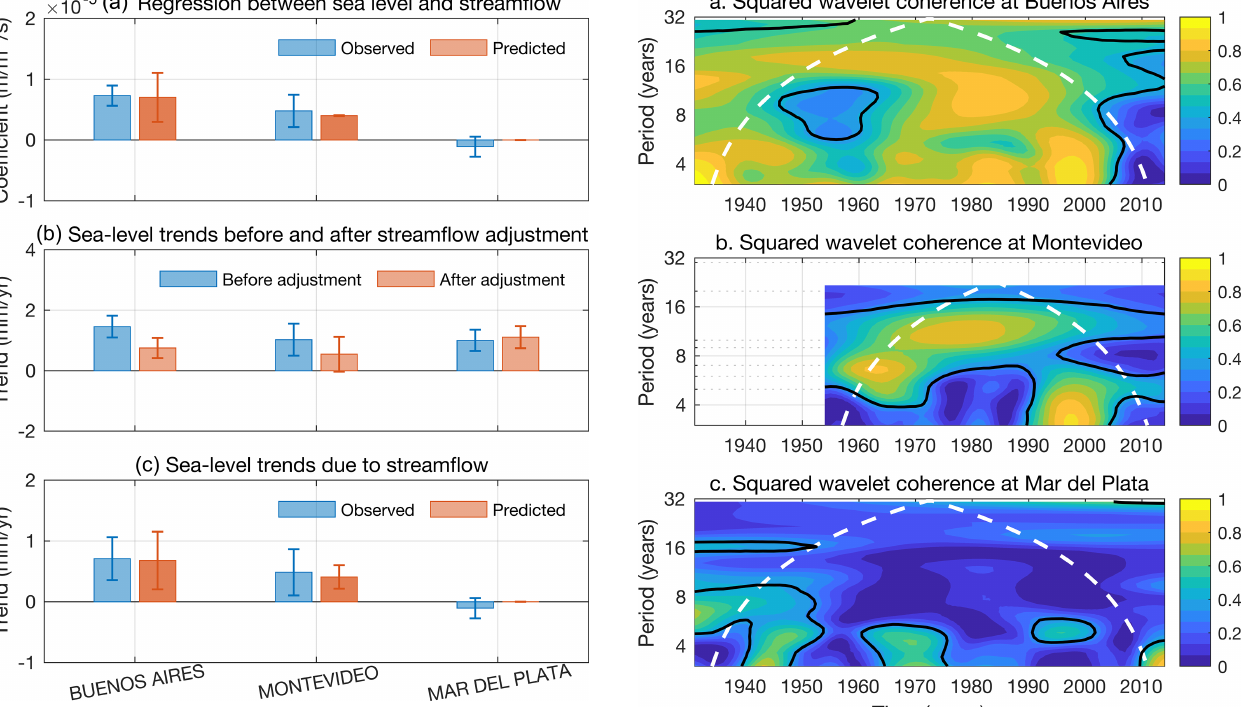
Figure 7. (a) Regression coefficients between sea level and stream- flow found empirically from linear regression (blue) and predicted theoretically from ocean dynamics (orange). (b) Trend computed from tide gauges without (blue) and with (orange) adjusting for river effects. (c) Sea-level trend due to streamflow found empiri- cally from linear regression (blue) and predicted theoretically from ocean dynamics given the streamflow trend (orange). To evaluate predicted values at Buenos Aires, I use a value of x = 65km from the source in Eq. (13).